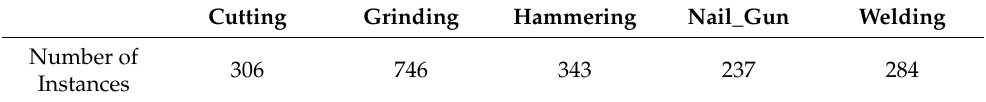
Table 1. The number of 10 s audio segments covering individual construction activities.